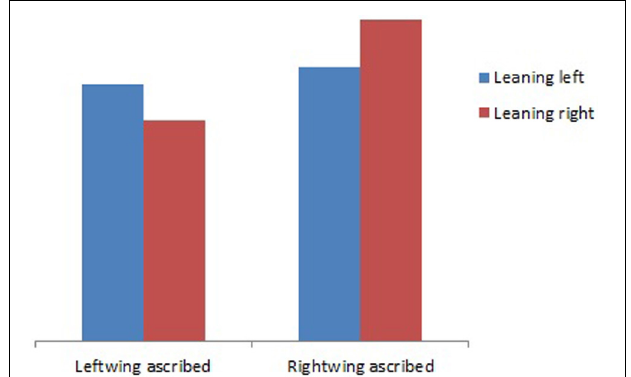
FIGURE 2 | Ascribed statements to left- and right-wing parties by leaning